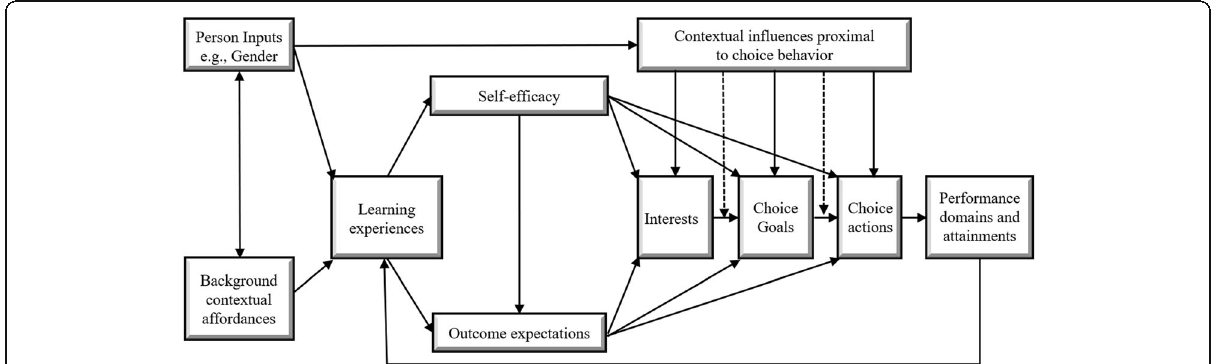
Fig. 1 The choice model of social cognitive career theory (adapted from Lent et al.,